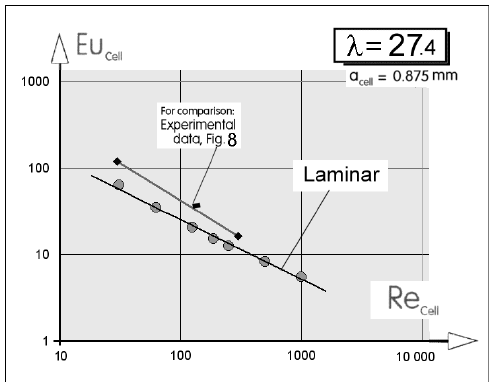
Figure 13. Pressure drops across a longer computation domain—still very much shorter than the matrix passage length in the experiment, Figure 8—obtained by numerical solutions assuming laminar flow.